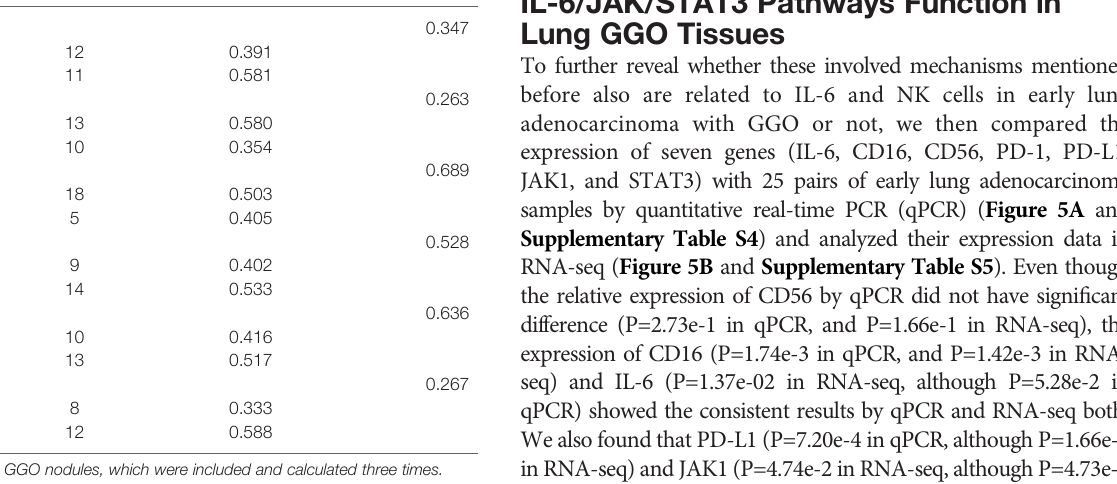
TABLE 2 | The fold change (FC) of NK cell expression level with main characteristic of the GGOs in the fl ow cytometry. Characteristics